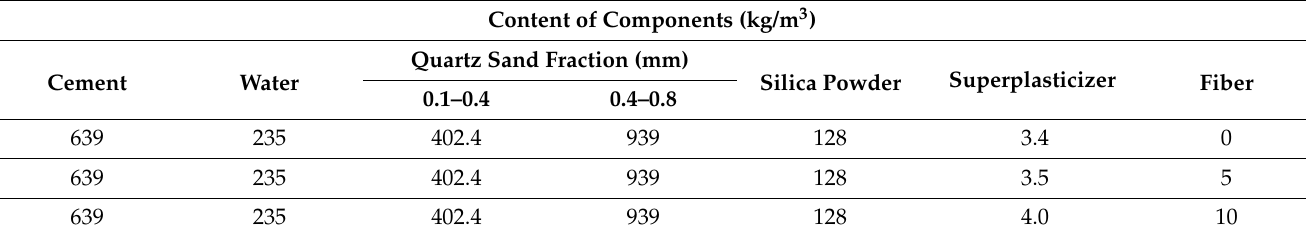
Table 6. Composition of concrete mixture with treated